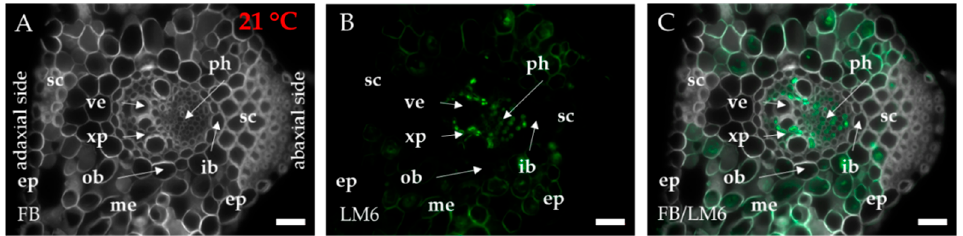
Figure A4. Immunolocalisation of the LM6 epitope ( A – C ) in cross ‐ sections of B. distachyon leaves (21 °C), through the major vascular bundle. The white arrows point to the respective parts of the leaf.